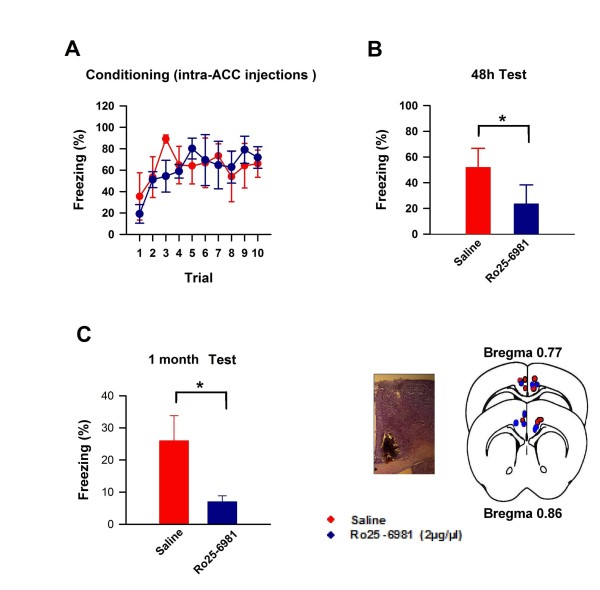
GluN2B subunit activity within the ACC is necessary for trace fear learning. (A) Mice exposed to bilateral 0.5 μl infusions into the ACC of either Ro25-6981 (2 μg/μl) or saline 15 minutes prior to trace fear training exhibited similar learning curves. (B) Mice exposed to Ro25-6981 prior to training showed a significant reduction in freezing behavior in response to the CS when tested in a new context 48 h later (saline: n = 4; Ro25-6981: n = 4, t = 3.06). (C) (Left) The memory impairment was still evident one month after training. (Right) Representative markers indicating microinjection locations. (* P < 0.02).